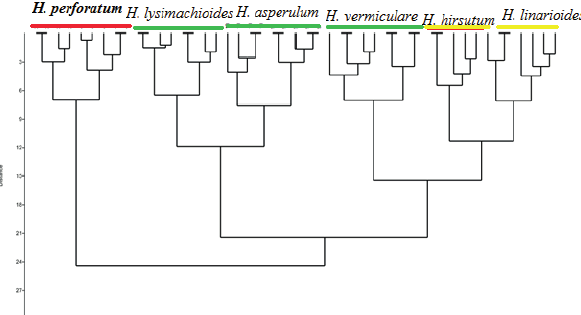
Figure 3. WARD tree of SRAP data revealing species delimitation in the Hypericum